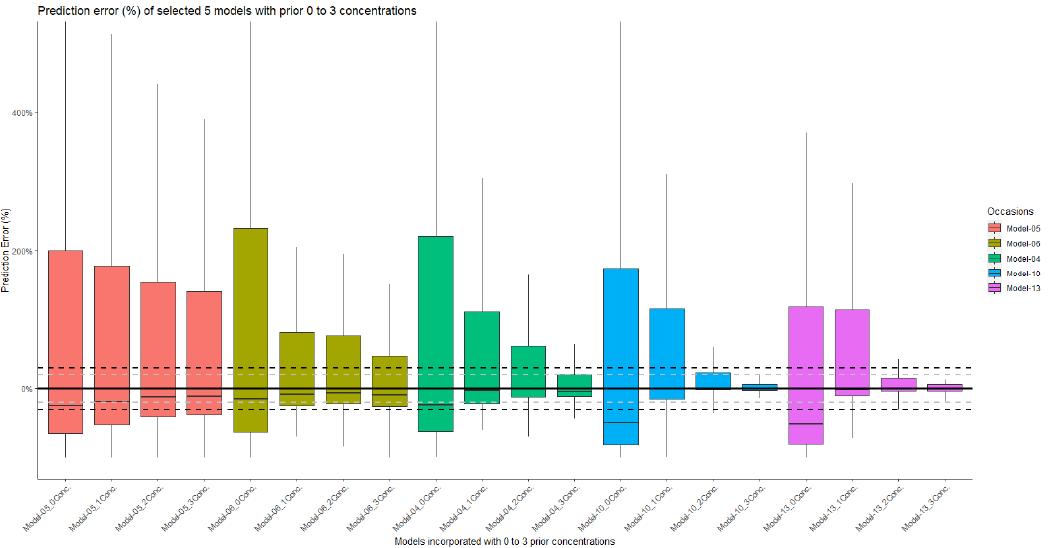
Figure 4. Prediction errors of model 5, 6, 4, 10 and 13. For each model, none, one, two or three plasma concentrations were used to improve the model fit. The grey dashed line is the y = ± 20%. The black dashed line is the y = ±